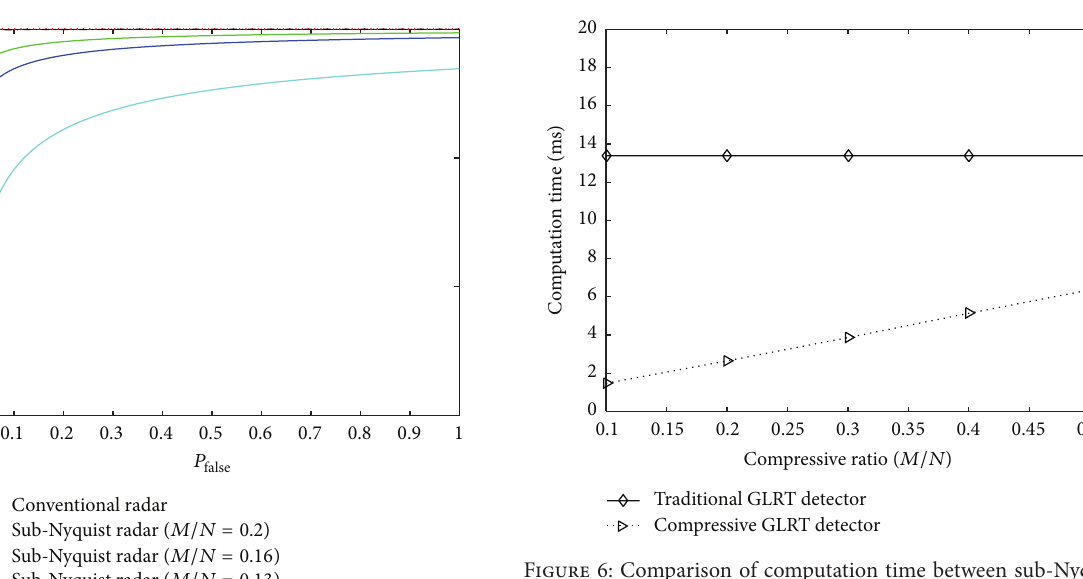
Figure 6: Comparison of computation time between sub-Nyquist radar and conventional